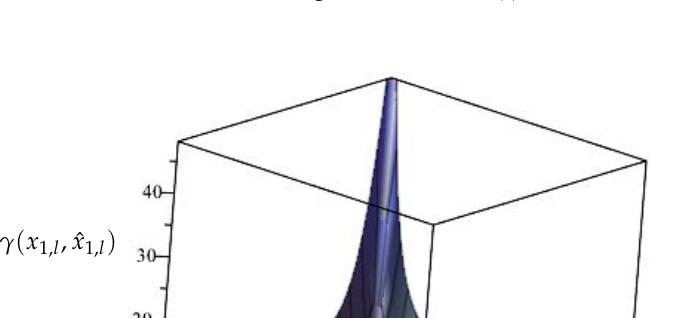
Figure 8. Function h ( · ) .